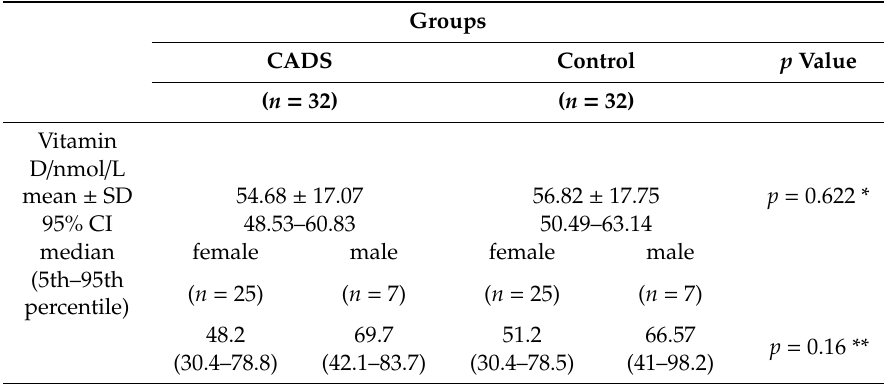
Table 2. Serum vitamin D level according the groups and gender. Groups